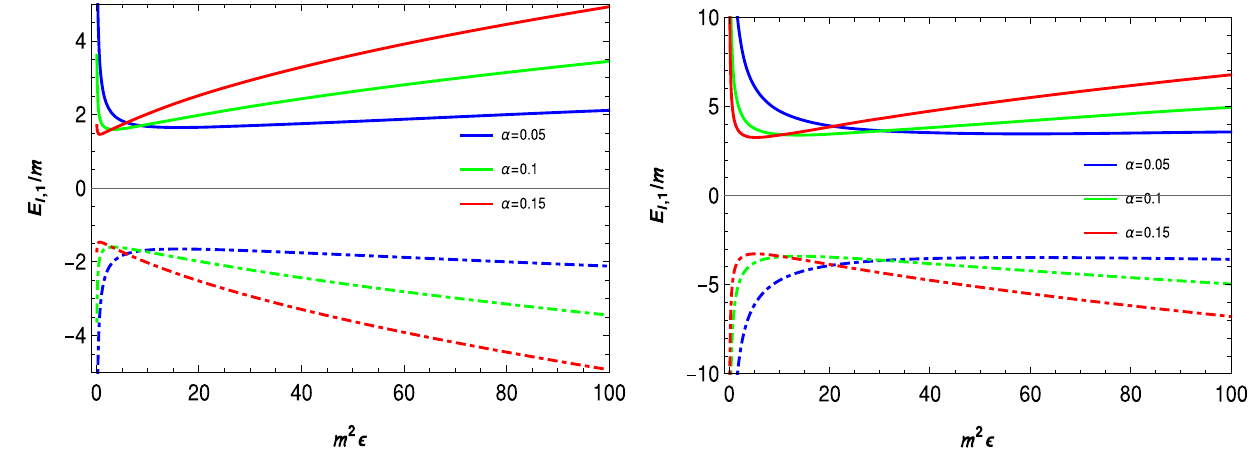
| as a function of m 2 (cid:4) . Fig. 6 In both figures we are visualizing | E l , 1 positive sign of the energy spectrum Eq. (35) and the dotted curves the m negative sign. On the curve on the right, we fix the parameter ξ = 0 . 3 In the figure on the left, we fixed the parameter ξ = 0 . 1 and varied and vary the parameter α . In both cases, we set ω/ m = l = some values for the parameter α . The continuous curves represent the